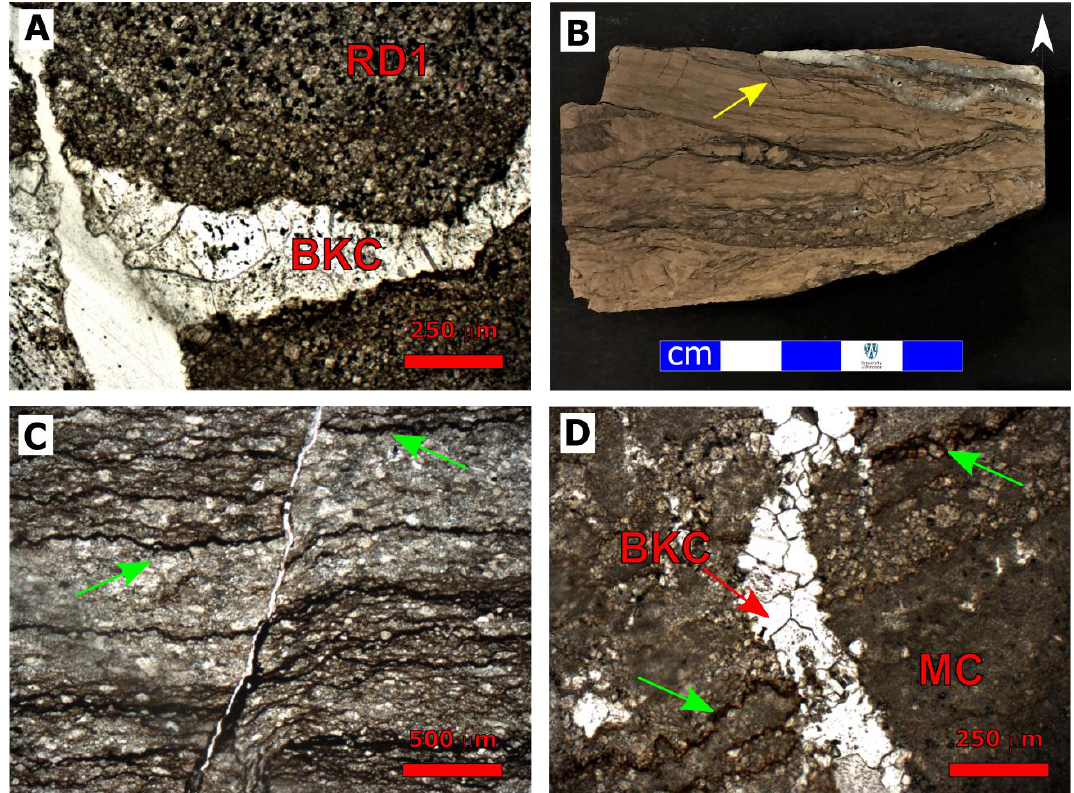
Figure 8. Fracturing in Devonian formation. ( A ) Photomicrograph (PPL) of a sub-vertical, unfilled hairline fracture cross-cutting sub-horizontal blocky calcite (BKC) vein in a fine crystalline dolostone. Sample 8-1; well: DGR8-CR10; depth: 22.71 m; ( B ) Core photograph showing two systems of fractures in a dolostone from the Lucas Formation (Devonian). A sub-vertical unfilled hairline fracture (yellow arrow) crosscut a sub-horizontal fracture-filled by late calcite cement. The white arrow indicates the top of the sedimentary sequence. Sample 8-1; well: DGR8-CR10; depth: 22.71 m. ( C ) Photomicrograph (PPL) of a sub-vertical, unfilled hairline fracture crosscutting and displacing dissolution seams (green arrows) and sedimentary structures in a partially dolomitized grainstone. Sample 1-9; well: DGR1-CR9; depth: 46.4 m; ( D ) photomicrograph (PPL) of sub-vertical, blocky calcite (BKC) vein cross-cutting dissolution seams and stylolites (green arrows) in a partially dolomitized limestone. Note the presence of undolomitized micritic matrix (MC) from the precursor limestone. Sample 1-2; well: DGR1-CR2 (1); depth: 26.25 m.